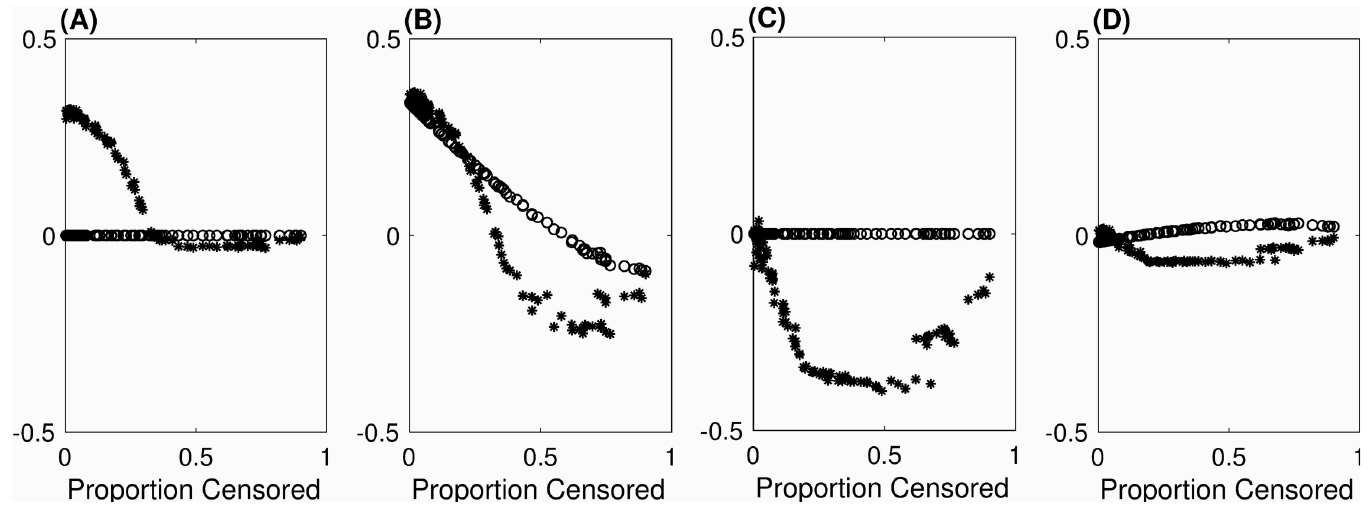
Fig 4. Simulated mean (o’s) and median ( � ’s) of RES distributions for (A) MR, (B) DR, (C) OLRR, (D) OTE.